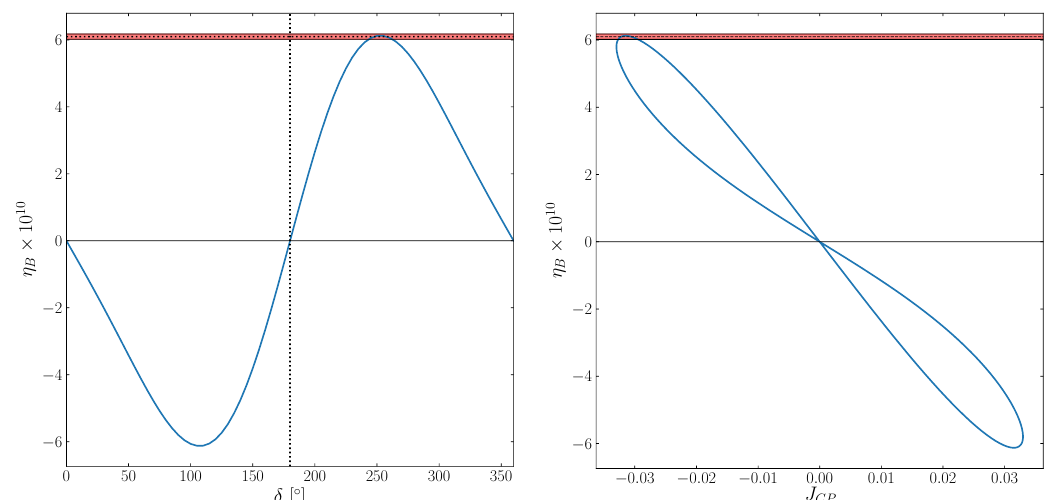
Figure 15 . Leptogenesis at high scales ( M 1 = 3 : 16 10 13 GeV) with CP violation provided solely (cid:2) by (cid:14) , with (cid:11) 21 = 0 (cid:14) and (cid:11) 31 = 0 (cid:14) . The red band indicates the 1 (cid:27) observed values for (cid:17) B with the best-(cid:12)t value indicated by the horizontal black dotted lines. Left: the baryon asymmetry as a function of (cid:14) with exact CP -invariance exists for (cid:14) = 0 (cid:14) and 180 (cid:14) (vertical black dotted lines). In order to make the maximum value touch on the observed baryon asymmetry, an amount of (cid:12)ne- tuning = 105 is needed. Right: the corresponding variation of (cid:17) B against J CP parametrically F plotted with (cid:14) . See the text for further details.